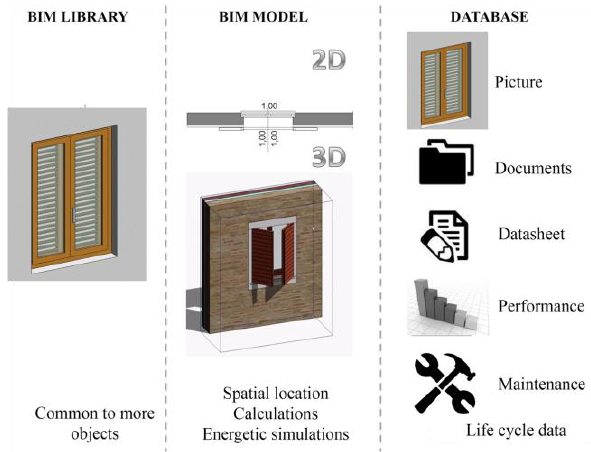
Figure 10: Part of the database with graphic interface for the management and maintenance of a